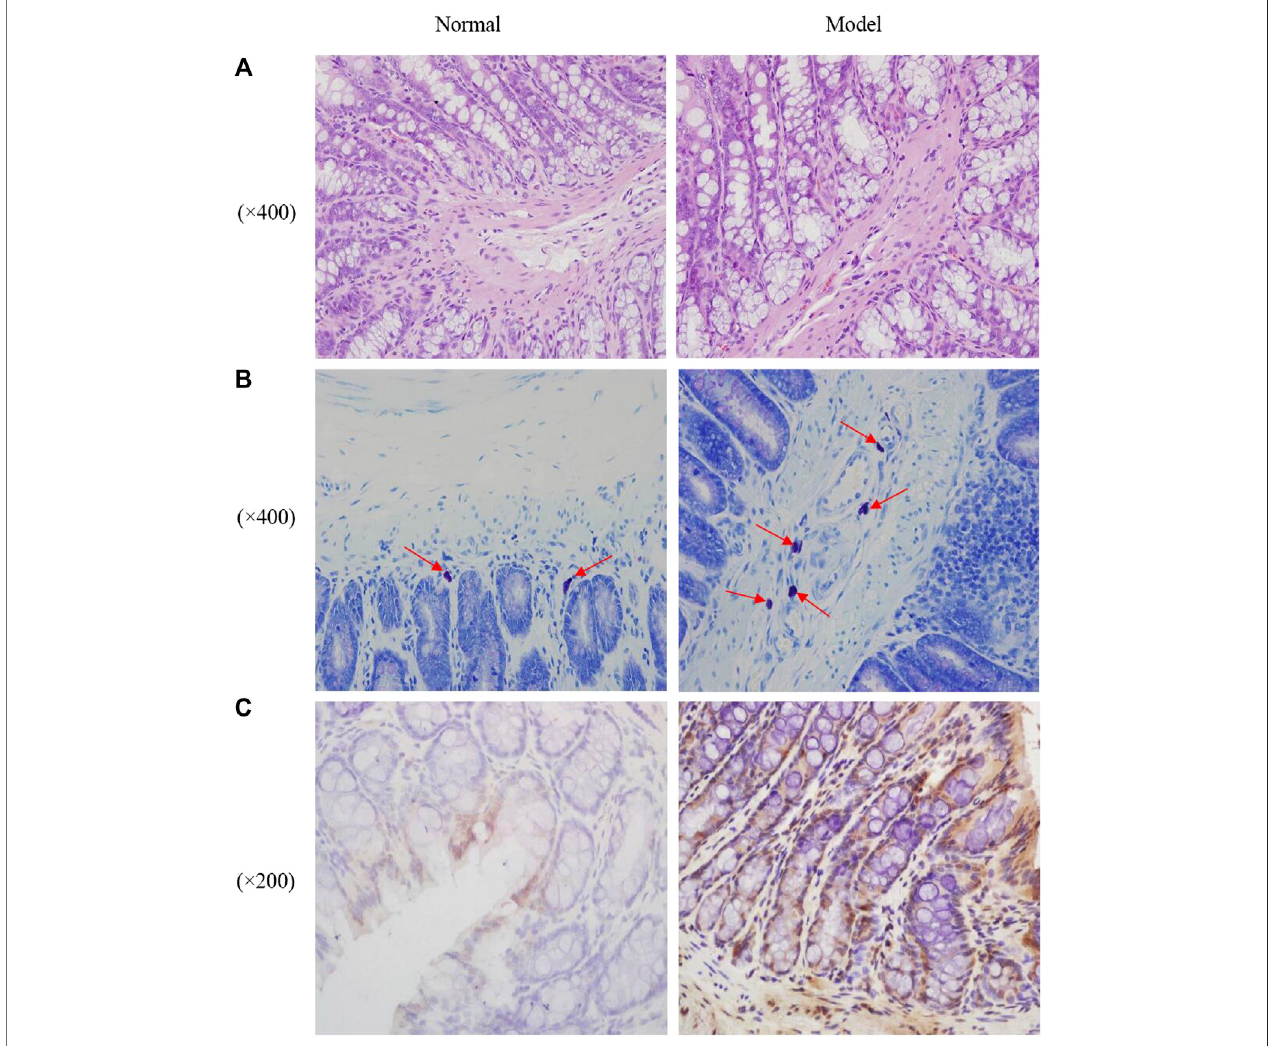
FIGURE2| PhotomicrographsofdistalcolonsbyHEstaining (A) ,mastcellinproximalcolonsbytoluidinebluestaining[ (B) ,theredarrowsindicatedthemastcells] and the expression of c-fos in the rats colon (C) .